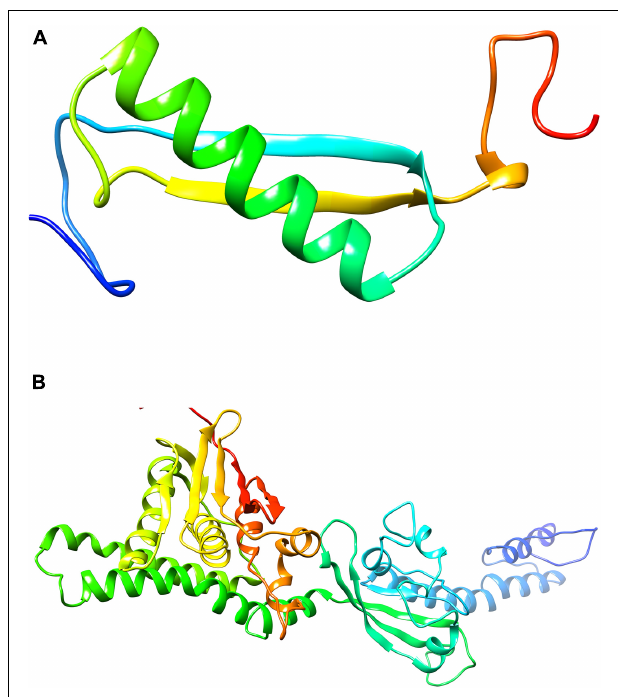
FIGURE 4 | Modeled structure of proteins (drug targets): Structure modeled through Homology modeler for 4-oxalocrotonate tautomerase (A) and sensor histidine kinases (B) using the respective